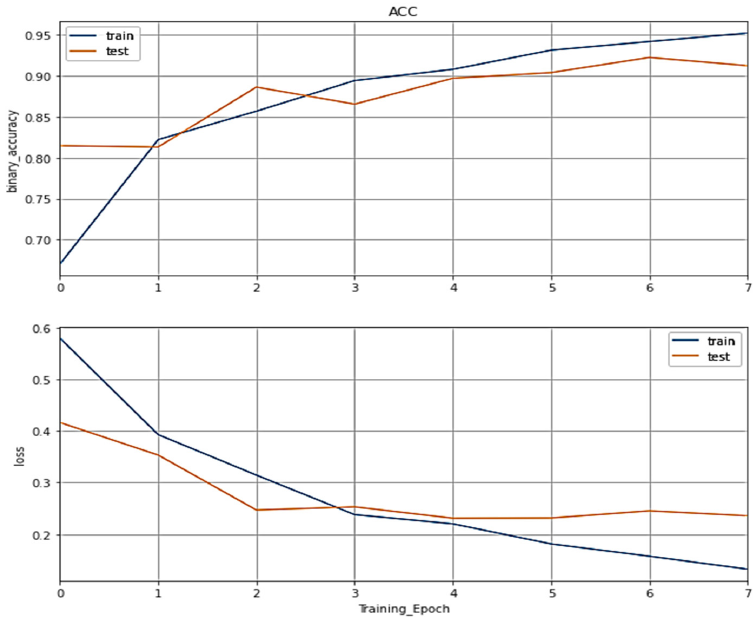
Figure 15. Training results and error values of convolutional neural networks.